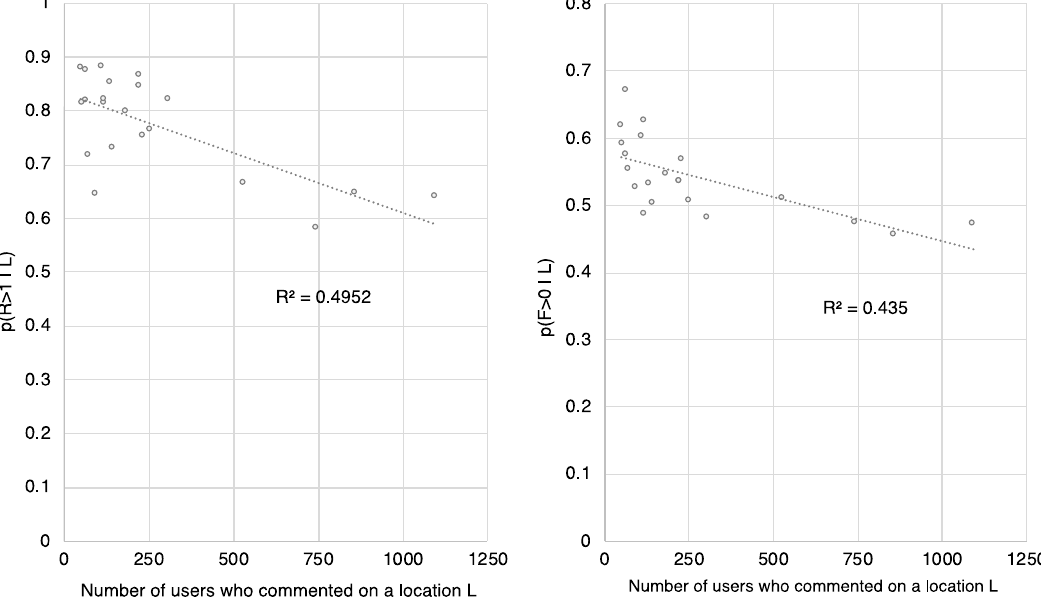
Figure 7. The scatterplot on the left side shows the correlation between popularity of locations L, measured by the number of users who commented on that location, and percentage of those users who have commented on more than one place, p ( R > 1 | L ) . The graphic on the right side visualizes the correlation between location popularity and the percentage of users commenting on location x who have followers, p ( F > 0 | L ) . The 21 most frequently commented on places that were reviewed by at least 50 users were taken into account as data points. The likelihood of having followers ( F > 0 ) and reviewing multiple places ( R > 1 ) tends to be higher for users commenting on alternative destinations with lower number of comments.